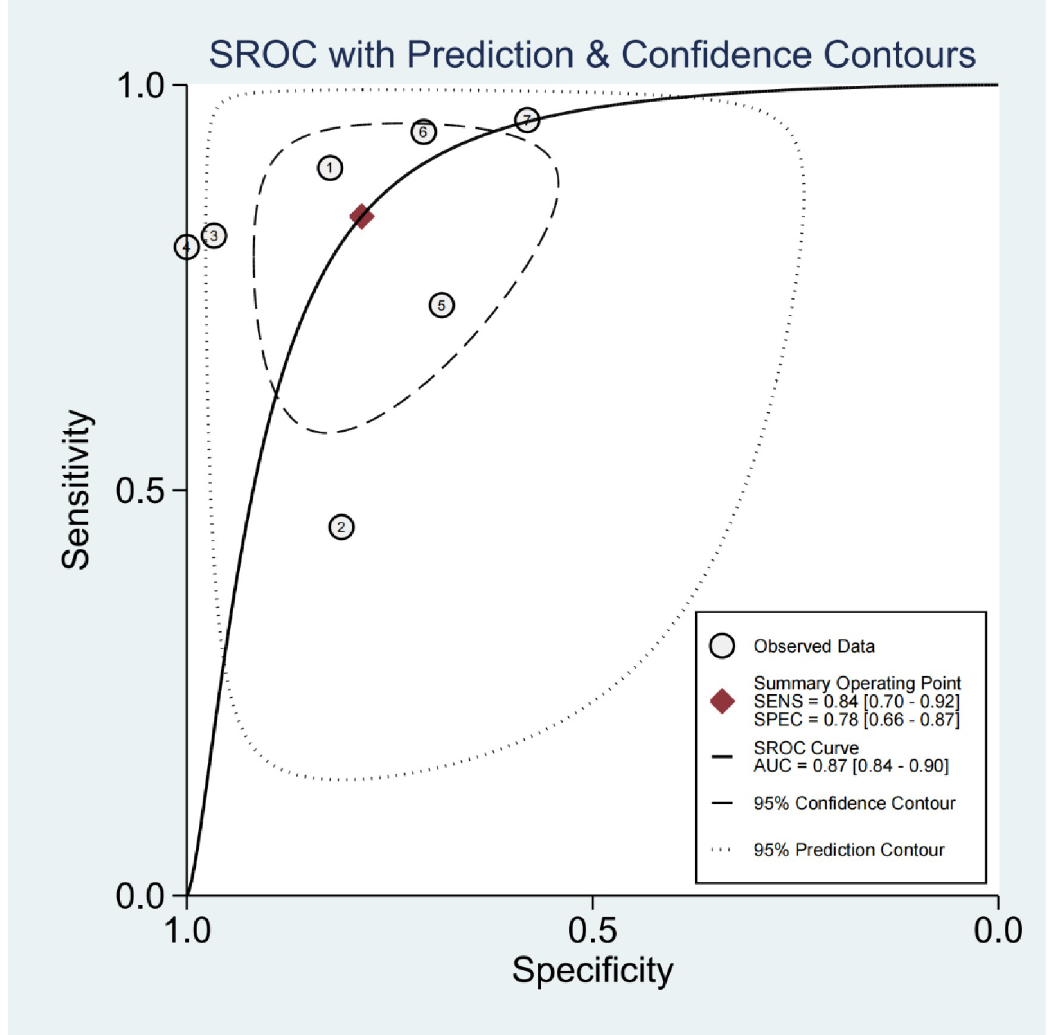
Fig 4. Summarize the receiver operating characteristic (SROC) curve and summarize the performance of interferon-gamma release assay in the diagnosis of OATB. Each study is represented by an open circle whose size is proportional to the inverse standard error of sensitivity and specificity. The filled square represents the summary estimate of the test accuracy, with the surrounding dashed zone outline denoting the 95% confidence region around this